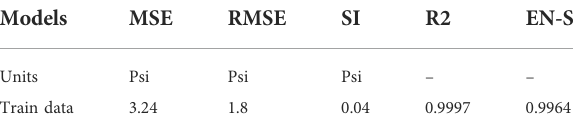
TABLE 3 Prediction of PP based on GS-GMDH model for well F 3 (1200 data point) based on wells F 1 and F 2 data points.